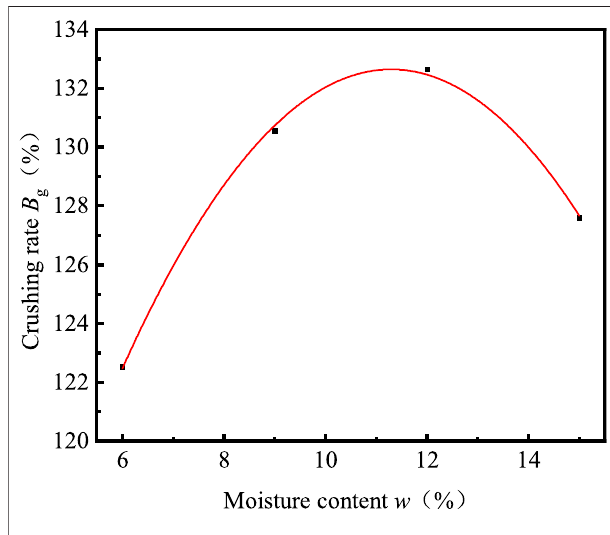
FIGURE 2 | Moisture content vs crushing rate.